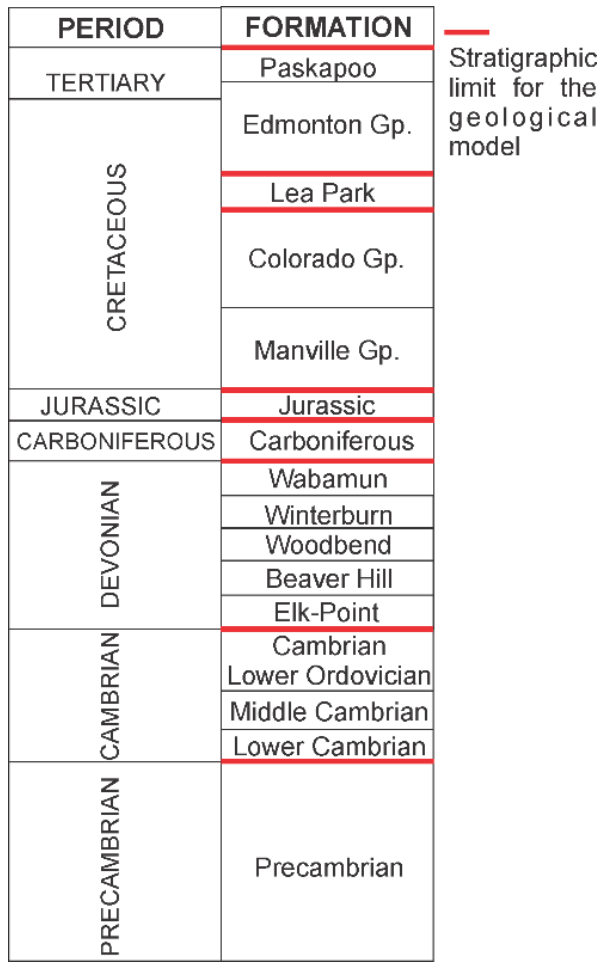
Figure 5. Stratigraphy and divisions of the geological model for the Alberta sedimentary Plains.